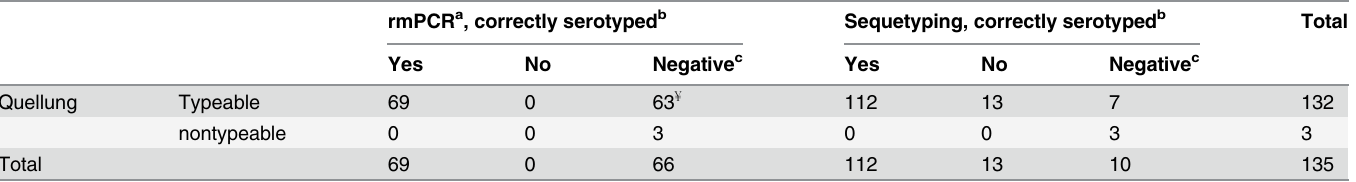
Table 3. Summary of molecular serotyping results of pneumococcal nasopharyngeal isolates from healthy children compared with the serotype determined by the Quellung reaction.